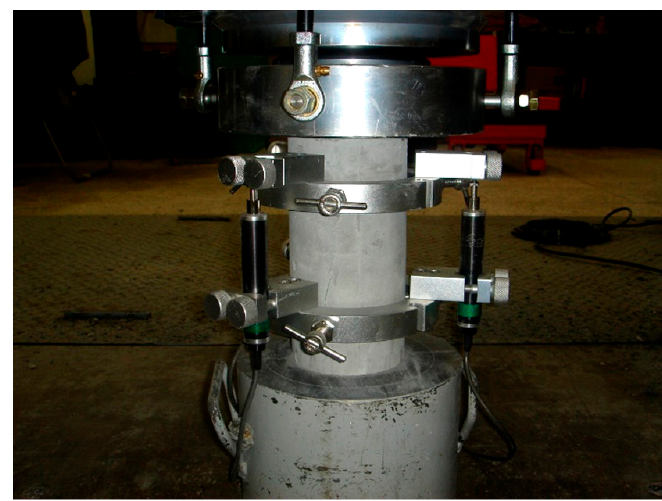
Figure 1. Experimental setup for the compressive strength and MOE measurements.